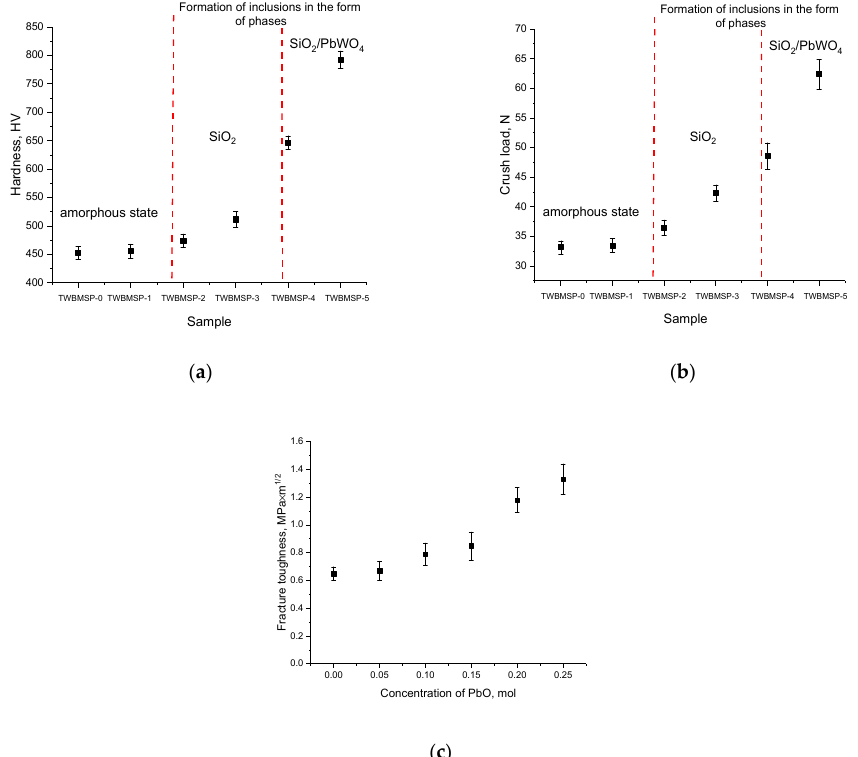
Figure 8. Results of the change in mechanical characteristics: ( a ) hardness data depending on the sample type; ( b ) single compression data; ( c ) fracture toughness data.